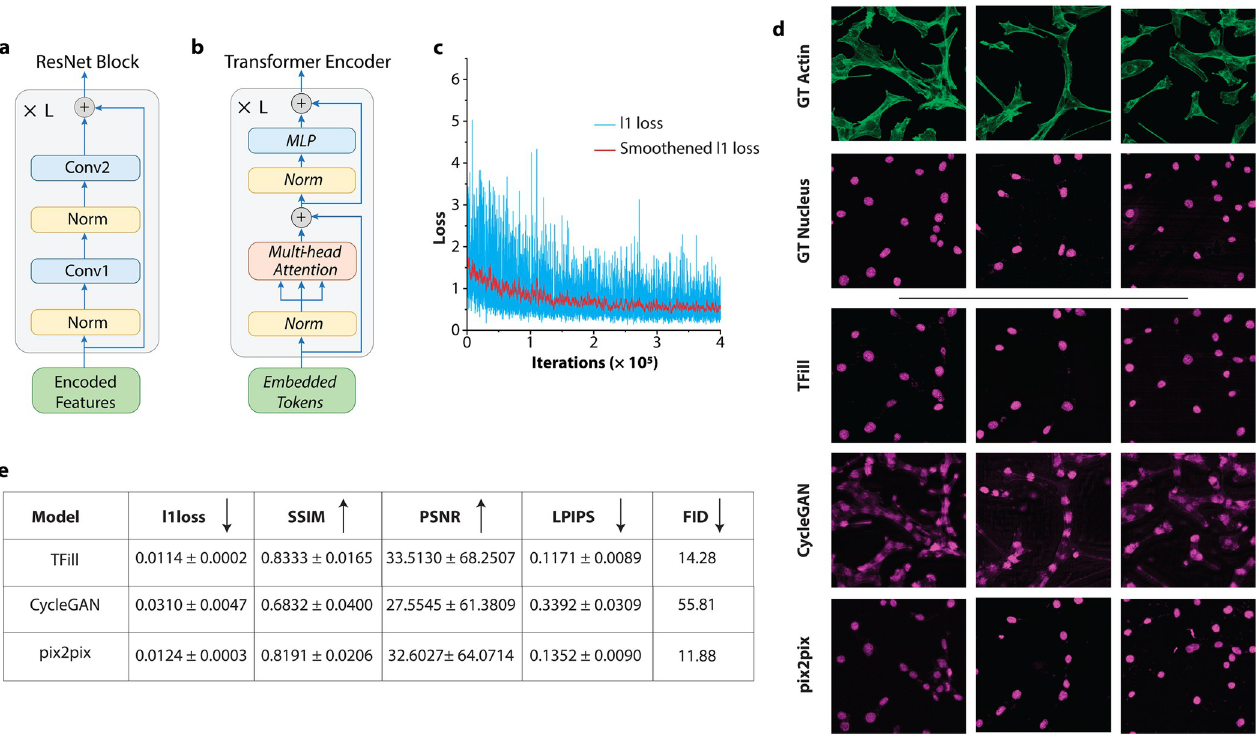
Fig 2. Assessing the performance of TFill network and comparison with state-of-the-art generative models. a, Encoder and Decoder layers comprise of a traditional convolutional neural network (CNN)-based ResNet block. b, The detailed architecture of the transformer encoder with self-attention mechanism. c, Reconstruction loss convergence as a function of iterations. d, Visual comparison of TFill generated nuclei images with trending image translation models. e, Quantitative comparison of TFill generated images with other image translation models using various metrics from computer vision ( # Lower is better; " Higher is